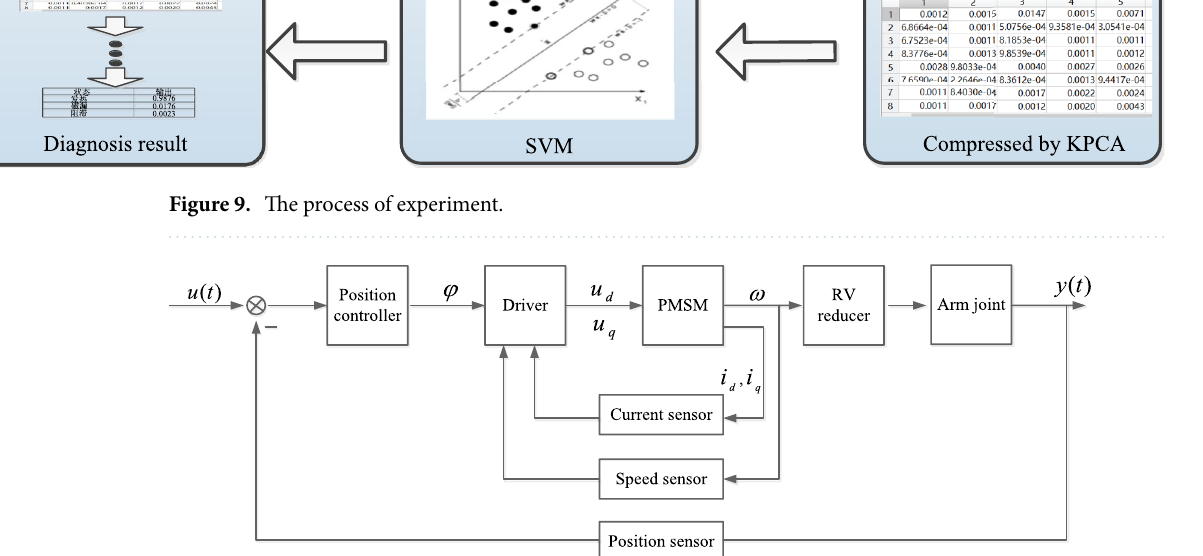
Figure10. The structure of industrial robot system.